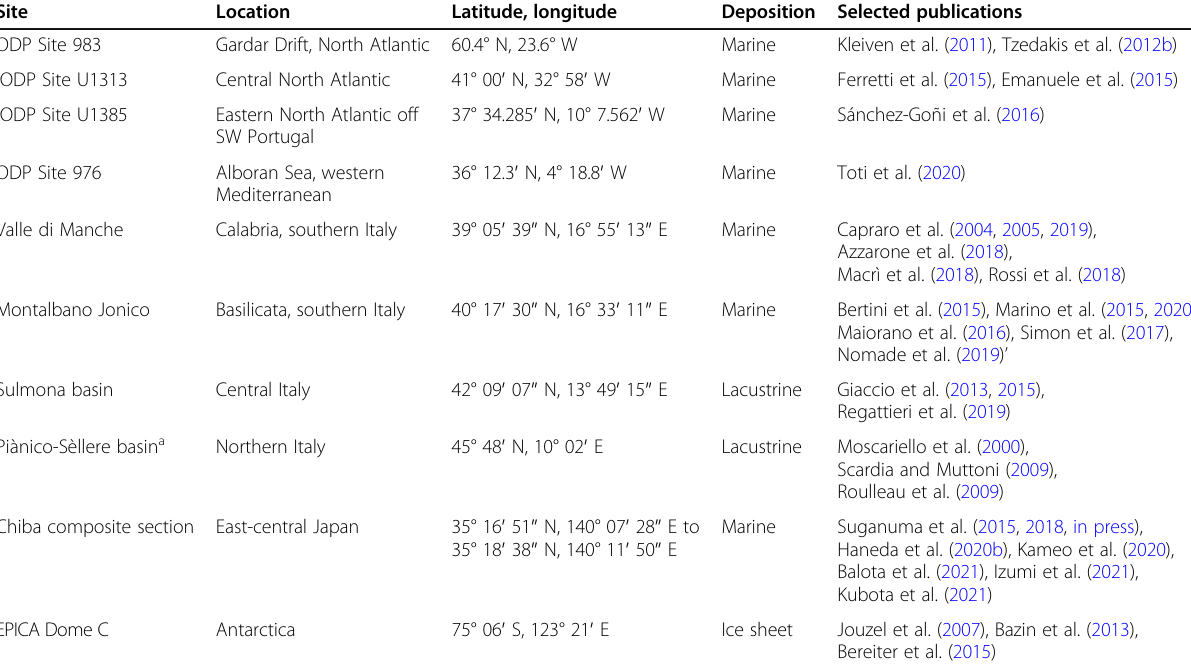
Table 3 Sites from which highly resolved paleoclimatic records of MIS 19 are